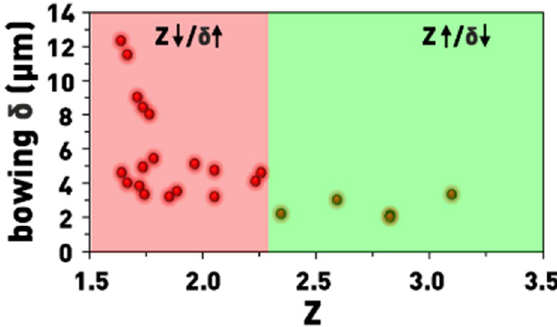
Figure 11. Parameter δ as a function of parameter